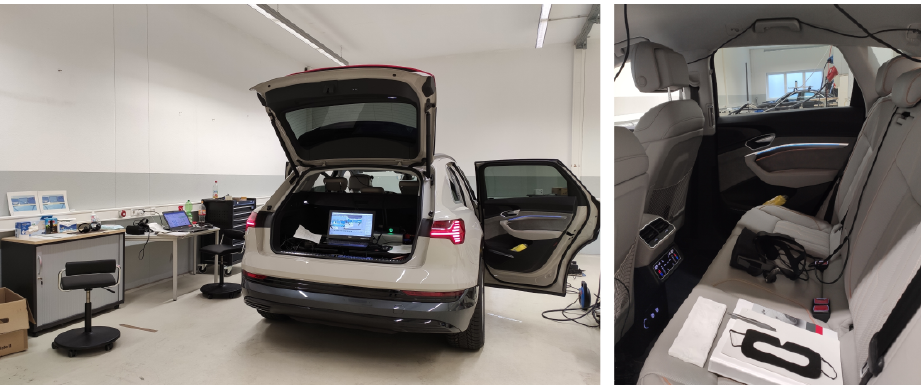
Figure 3. Our study was completed in the rear seat of a stationary Audi e-tron. The necessary hardware was set up in the trunk of the car ( left ). The participant was asked to sit in the rear seat ( right ) with the Oculus headset and wires linked back to the